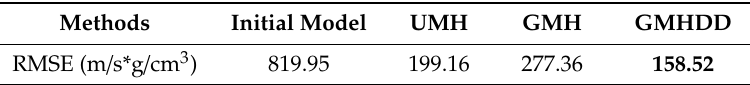
Table 2. The RMSE of three methods based on field